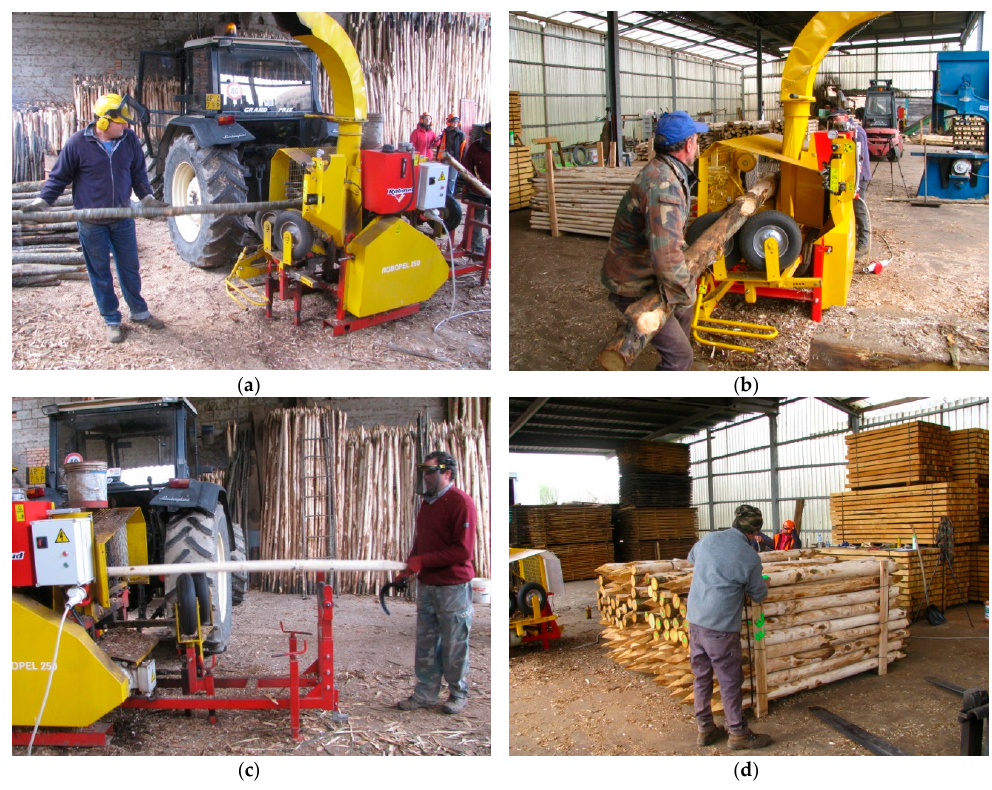
Figure 1. Typical postures assumed during post debarking at the two main work stations: loading-push ( a ), loading-hold ( b ), unloading-pull ( c ), and unloading-stack ( d ). All debarkers were manned by two workers: one for loading the undebarked posts and adjusting the machine during work, and the other for unloading the debarked posts and moving them to the appropriate stacks. Unloading was always manual, since no unloading deck was available. Sorting